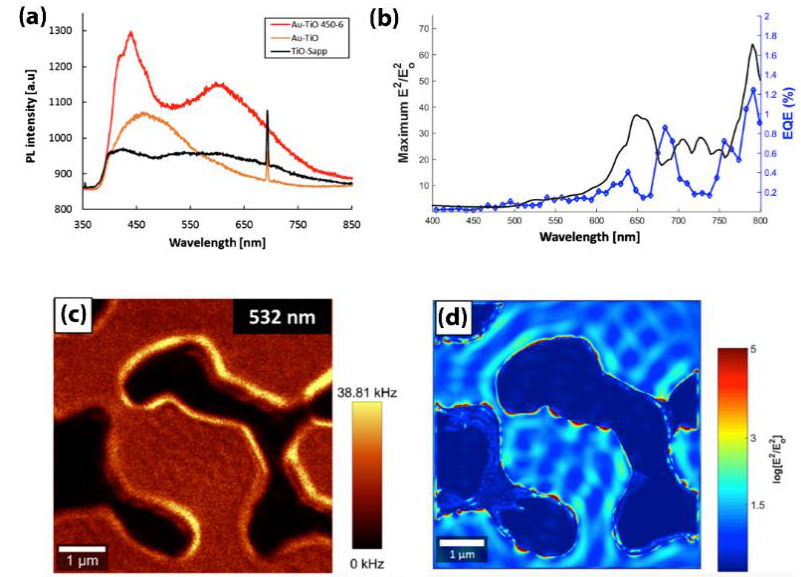
Figure 7. Annealed Au / TiO 2 responses: ( a ) photoluminescence; ( b ) external quantum e ffi ciency (EQE); ( c ) A SNOM map; and ( d ) corresponding FDTD simulation. Reproduced from [79]. with permission from Springer Nature, 2018.